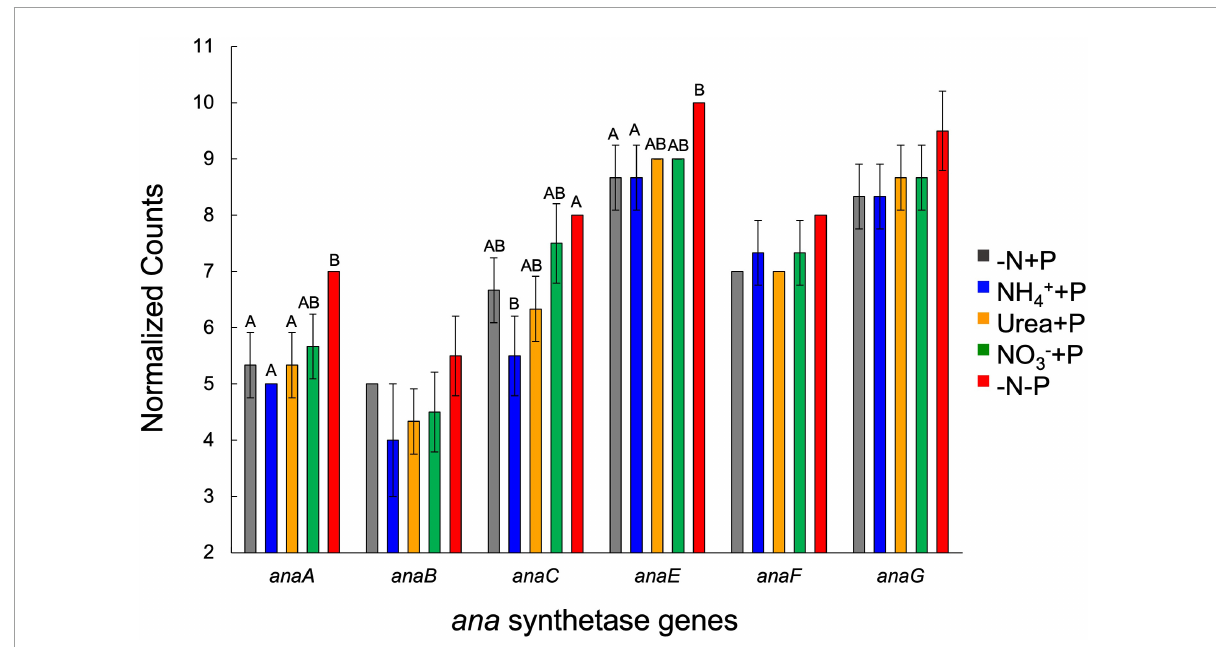
FIGURE10 Expression (normalized counts) of genes involved in anatoxin synthesis across treatments at the final timepoint (day 9). Error bars represent standard deviation. Letters above bars represent significant differences between experimental groups (Two-way ANOVA; Tukey’s HSD post hoc ; p <